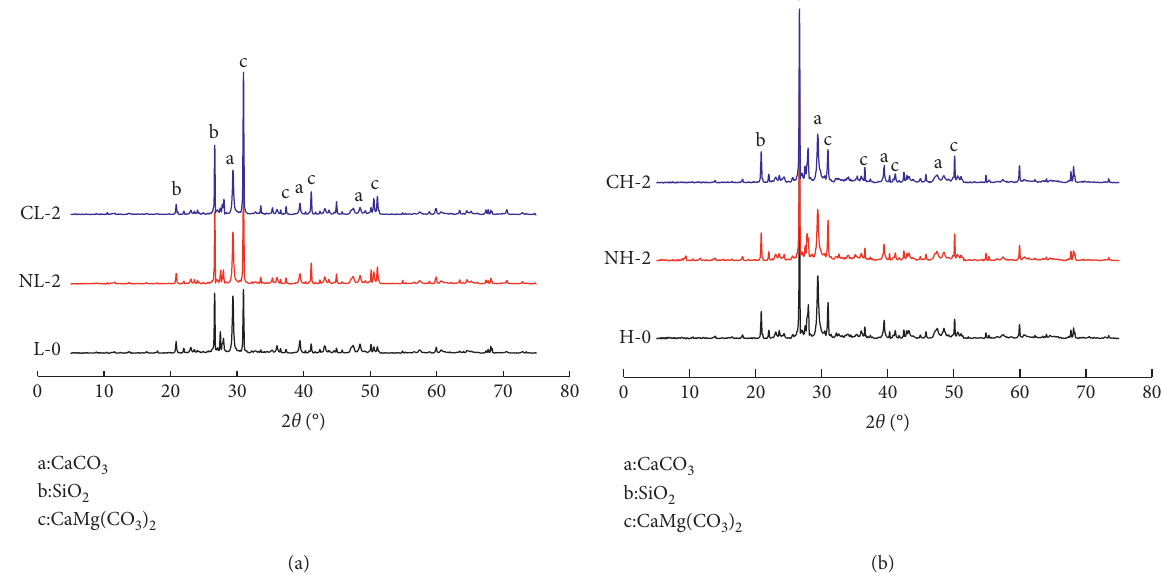
Figure 15: XRD of concrete carbonation zone. (a) L-0, NL-2, and CL-2. (b) H-0, NH-2, and